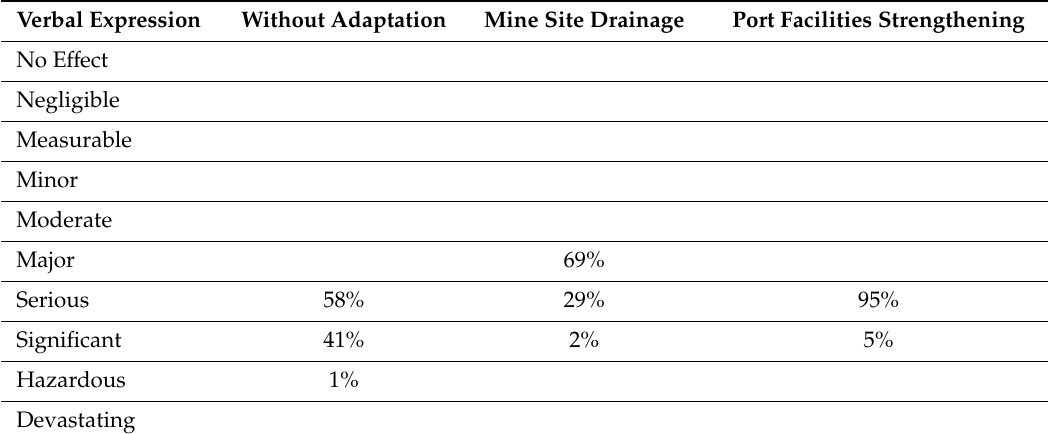
Table 8. Results of the discrete BBN for CLIRMI mine (economic losses in percentage of annual turnover).